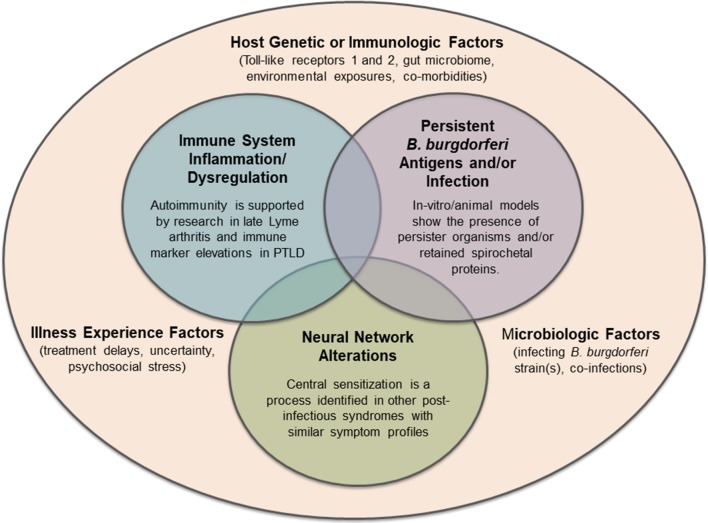
Hypotheses regarding potential mechanisms of persistent symptoms in Lyme disease, all of which may exist within the complex microbiologic, immunologic, genetic, and lived experience of individual patients. Future mechanisms of disease or other pre-disposing factors may still be identified.